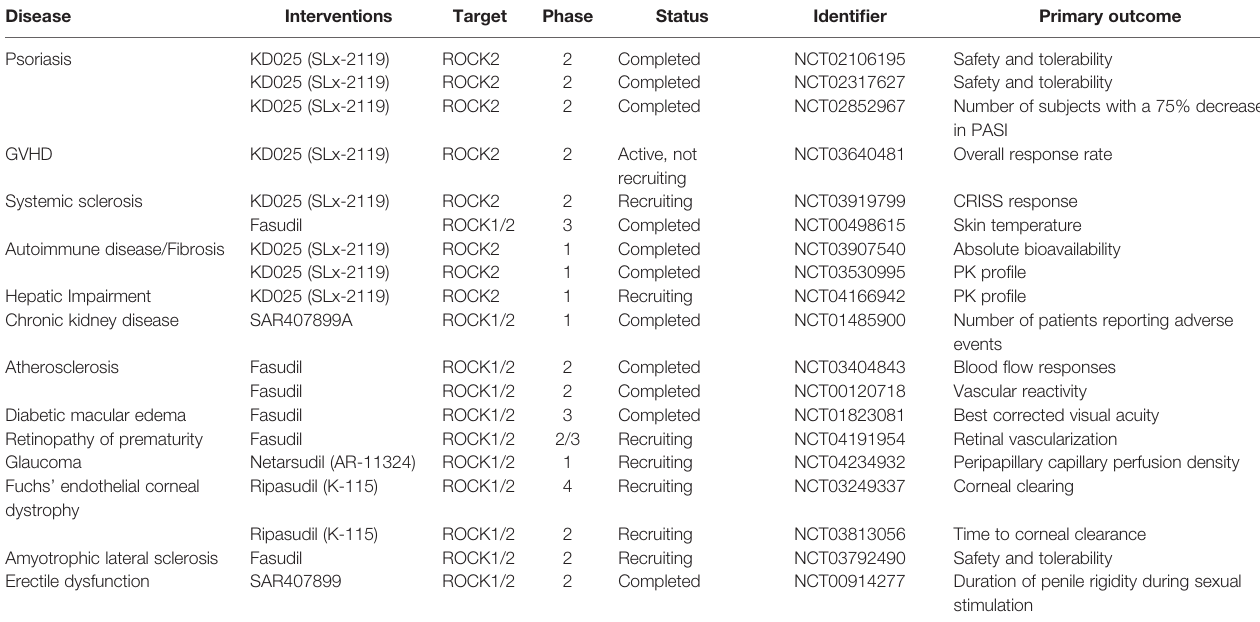
TABLE 1 | Clinical trials of ROCK inhibitors.